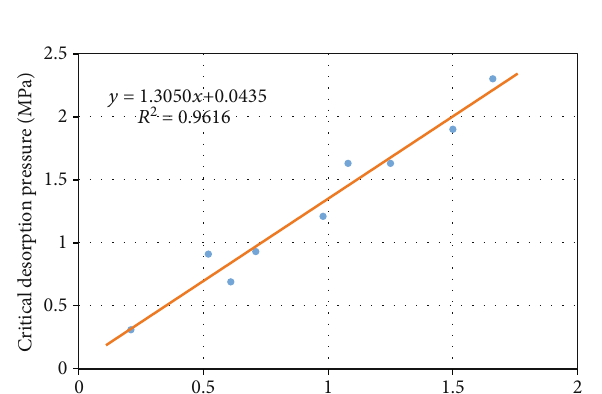
Figure 5: Linear regression corrects critical desorption pressure. Table 2: Critical desorption pressure and gas content of SZ block.